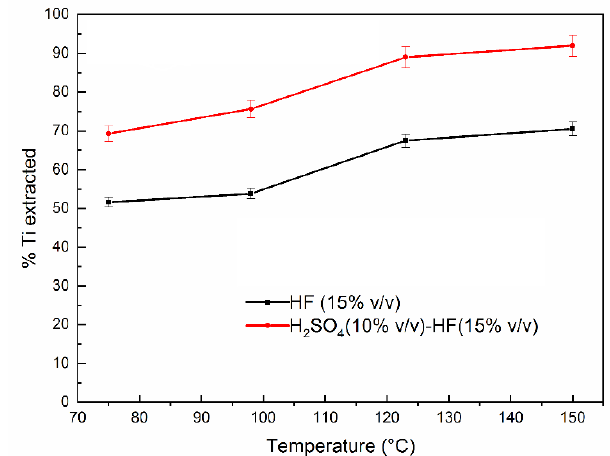
Figure 4. E ff ect of reaction Figure 4. Effect of reaction temperature.